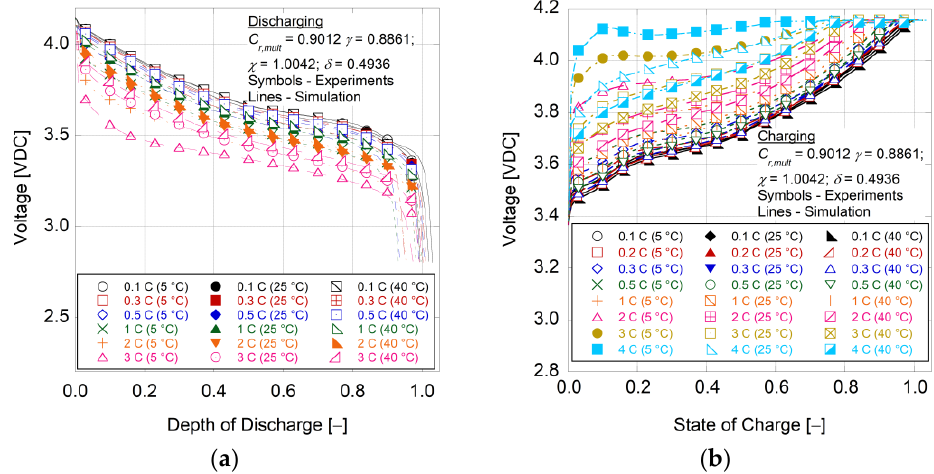
Figure 7. Experimental data and model results of a representative NCM 333 battery during ( a ) discharging and ( b ) charging events.